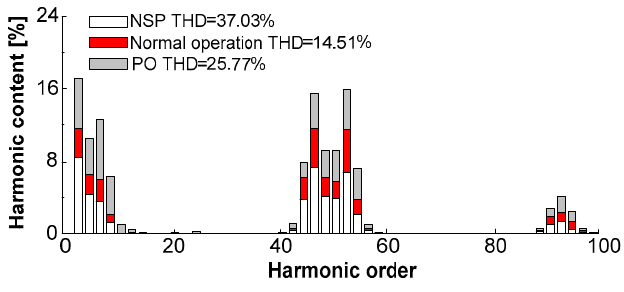
Figure 5. Measured harmonic distribution during a high-speed train passing the neutral section.